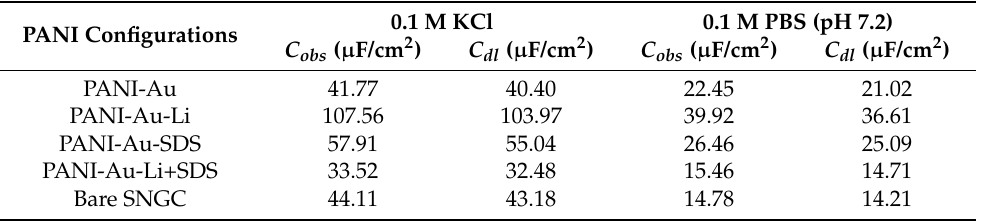
Table 1. Experimental values of C obs at 100 mV/s and C dl for the different configurations of PANI- based SNGC electrodes: PANI-Au synthesized without the use of dopants, PANI-Au-Li synthesized using 50 mM of LiClO 4 as dopant, PANI-Au-SDS synthesized using 5 mM of SDS as dopant, and PANI-Au-Li+SDS synthesized using 50 mM of LiClO 4 as dopant and 5 mM of SDS as stabilizer.